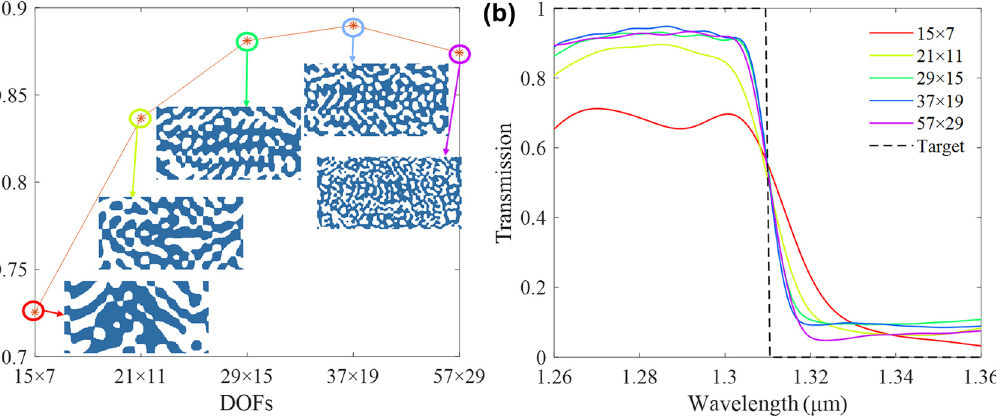
Figure 4: The investigation of impacts for different DOFs. (a) Optimized wavelength filters with five different DOFs as 15 × 7, 21 × 11, 29 × 15, 37 × 19 and 49 × 25. (b) Optical responses of five optimized wavelength filters with different DOFs, where the solid lines represent the simulated results and the dashed line represent the optical